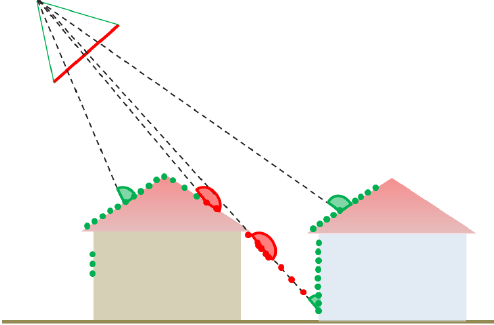
Figure 3. Schema of the mixed pixels filtering.